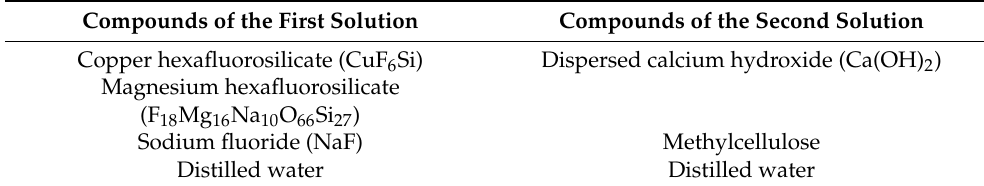
Table 1. Tiefenfluorid composition from the producer data sheet. Compounds of the First